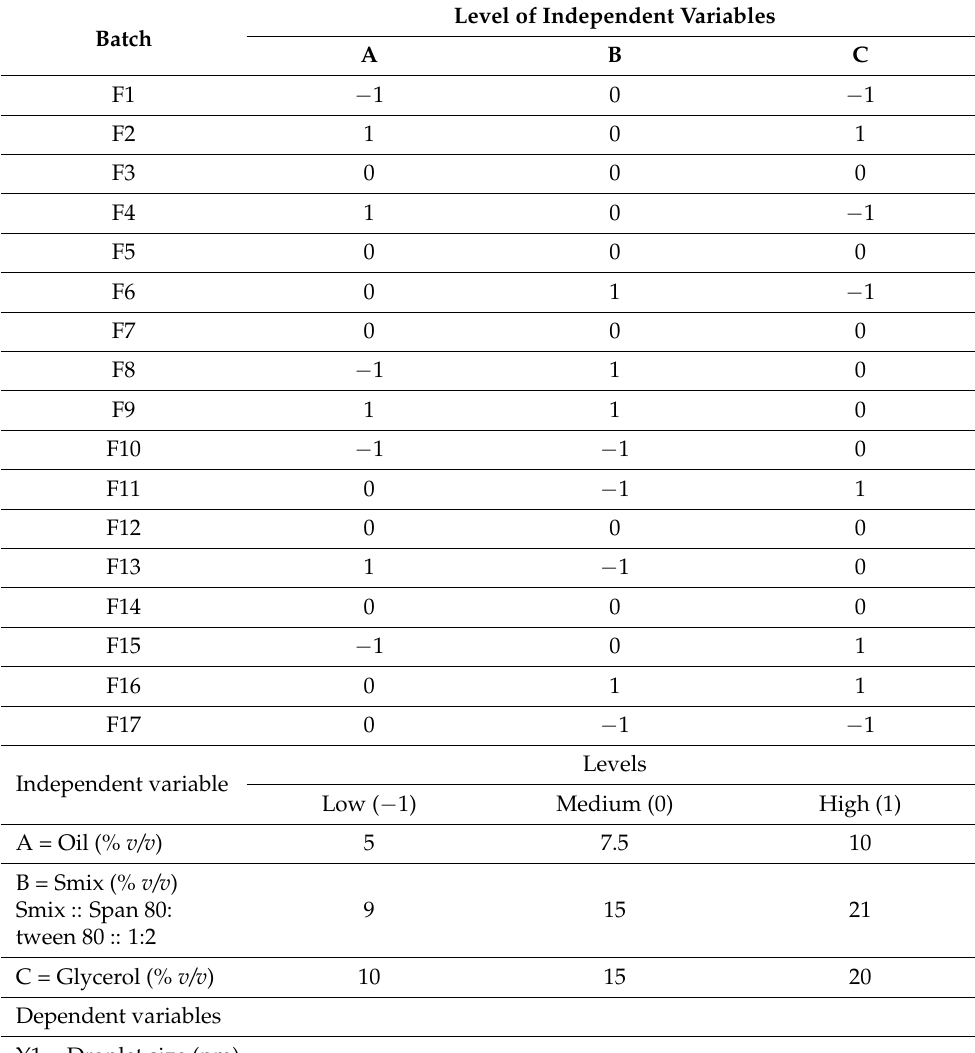
Table 1. Box–Behnken Design: three independent variables and their three